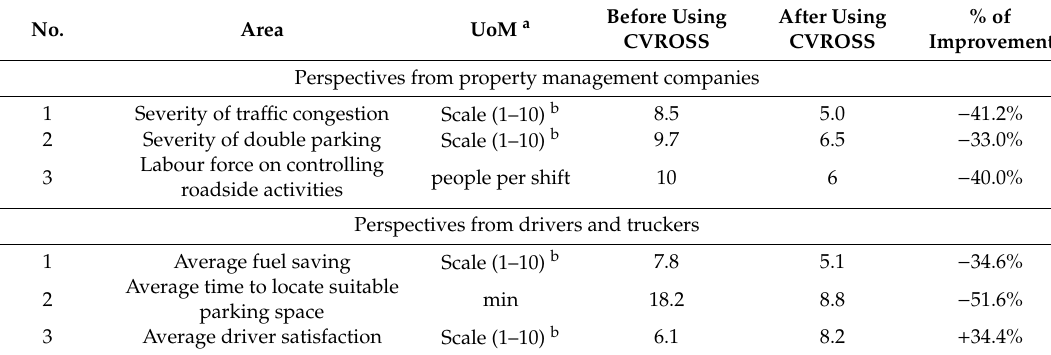
Table 2. Comparative analysis before and after using the